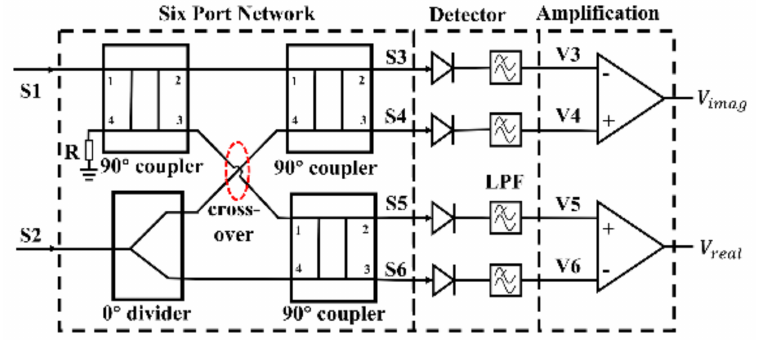
Figure 3. Topology of the complex cross-correlator circuit based on six-port